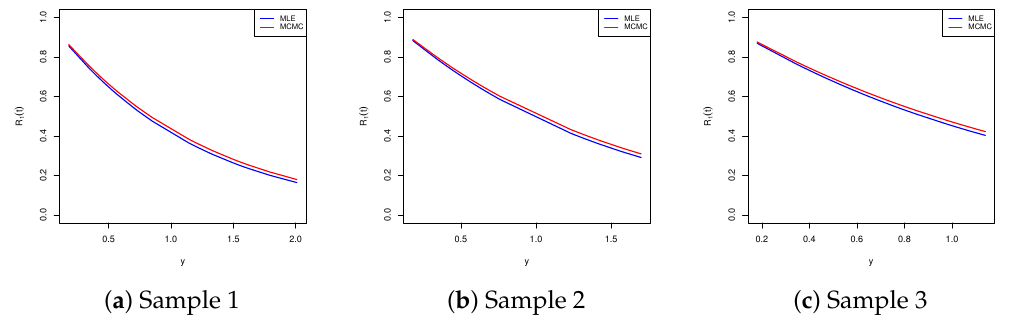
Figure 12. Point estimates of R 1 ( y ) from LED data.